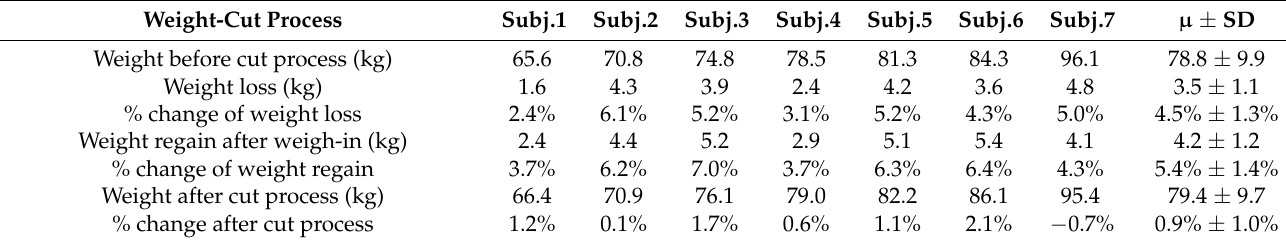
Table 2. Results of weight cutting of all subjects.